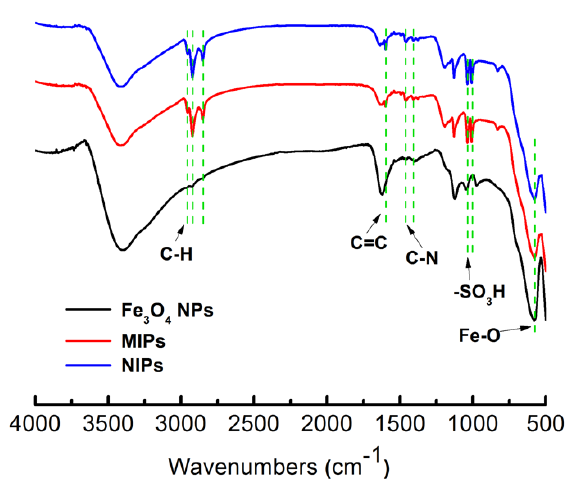
Figure 1. Fourier-transform infrared spectra of the Fe 3 O 4 nanoparticles (NPs), molecularly imprinted polymers (MIPs), and non-imprinted polymers (NIPs).